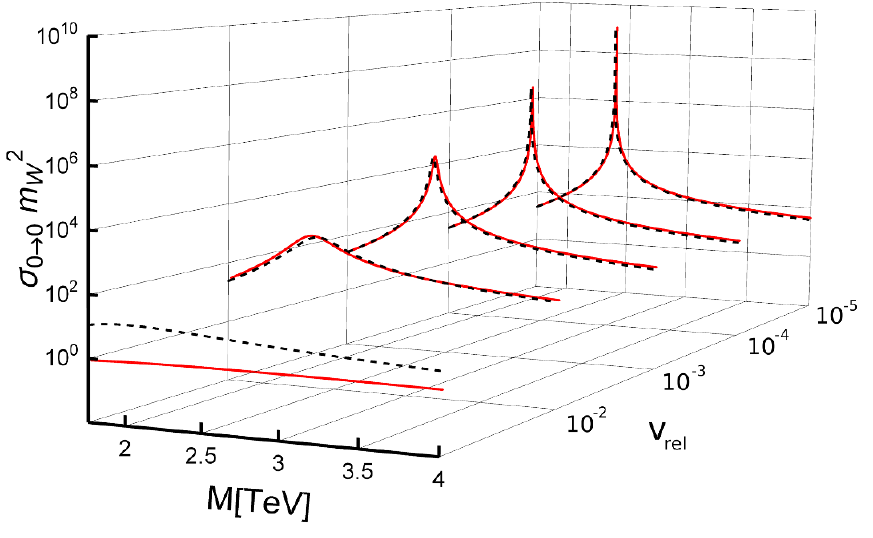
Figure 7 . The neutral-wino elastic cross section (cid:27) 0 ! 0 at (cid:12)xed relative velocity v rel = 2 v 0 as a function of the mass M . The relative velocities v rel are 10 (cid:0) 1 , 10 (cid:0) 2 , 10 (cid:0) 3 , 10 (cid:0) 4 , and 10 (cid:0) 5 , decreasing into the page. As v rel decreases, the universal cross section in eq. (3.16) (dashed curves) provides an increasingly accurate approximation to the cross section from solving the Schr(cid:127)odinger equation (solid curves) for M near the